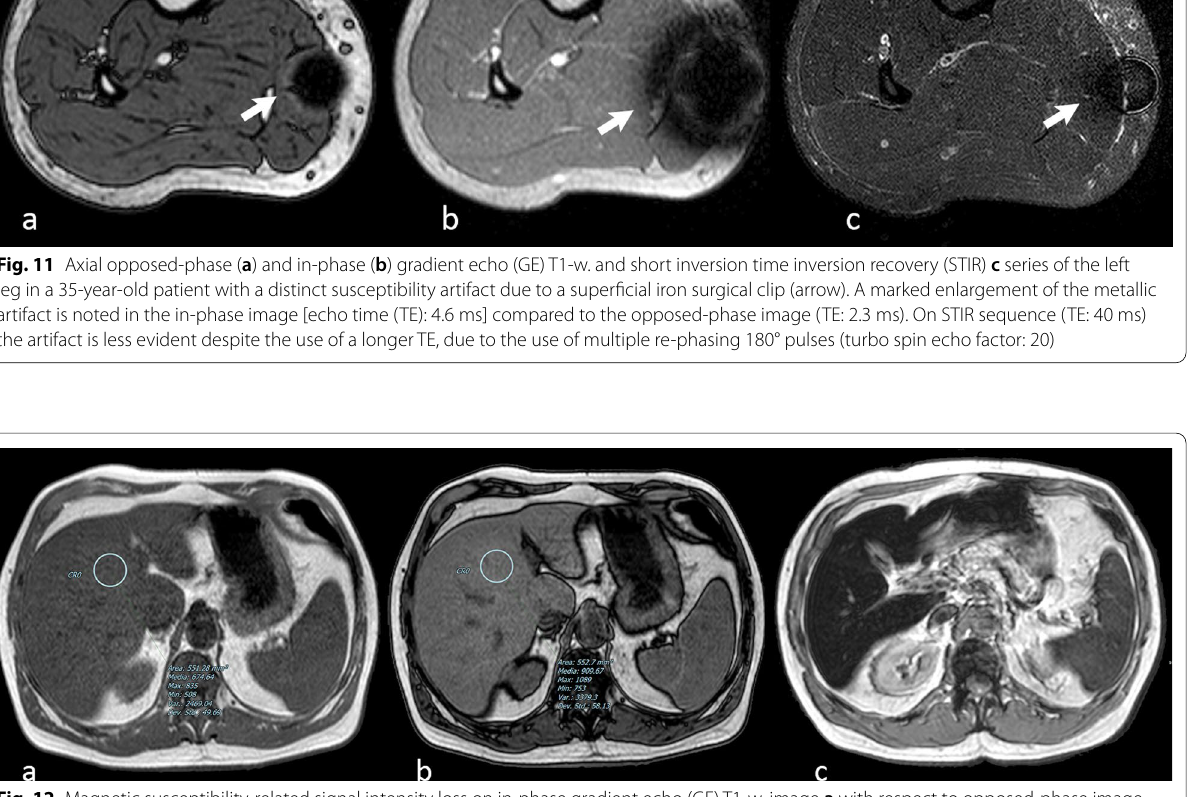
Fig. 12 Magnetic susceptibility-related signal intensity loss on in-phase gradient echo (GE) T1-w. image a with respect to opposed-phase image ( b ). The signal intensity loss is around 30% and is due to presence of hemosiderin in a patient with hepatic hemosiderosis. On turbo spin echo (TSE) T2-w. image ( c ) a marked hypointensity of the liver confirms the diagnosis of intra-hepatic hemosiderin